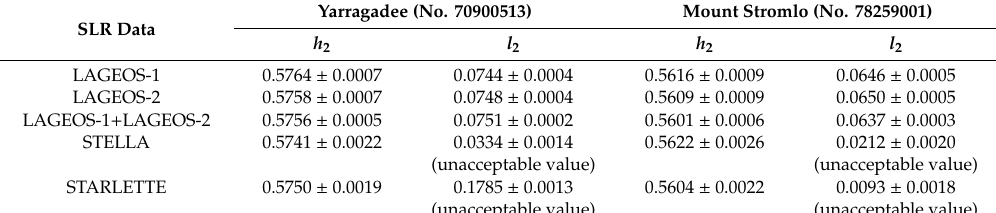
Table 1. Local tidal parameters h 2 , l 2 for Yarragadee and Mount Stromlo SLR stations.